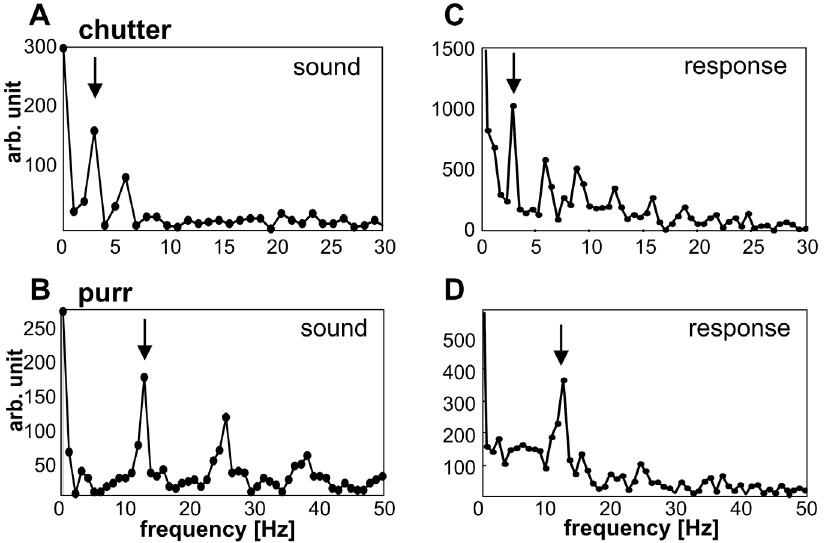
Figure 3. Coding of the vocalization frequency for chutter (A, C) and purr (B, D). The local maximum in the spectrum of the sound envelope (marked by an arrow in A and B) that corresponds to the average repetition rate of phrases can be detected in the frequency spectrum of the population PSTH (marked by an arrow in C and D) for chutter (C) and purr (D).